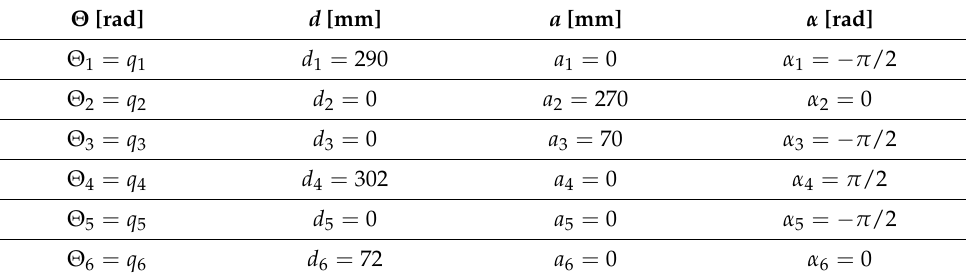
Table 1. The kinematic parameters of the analyzed robotic